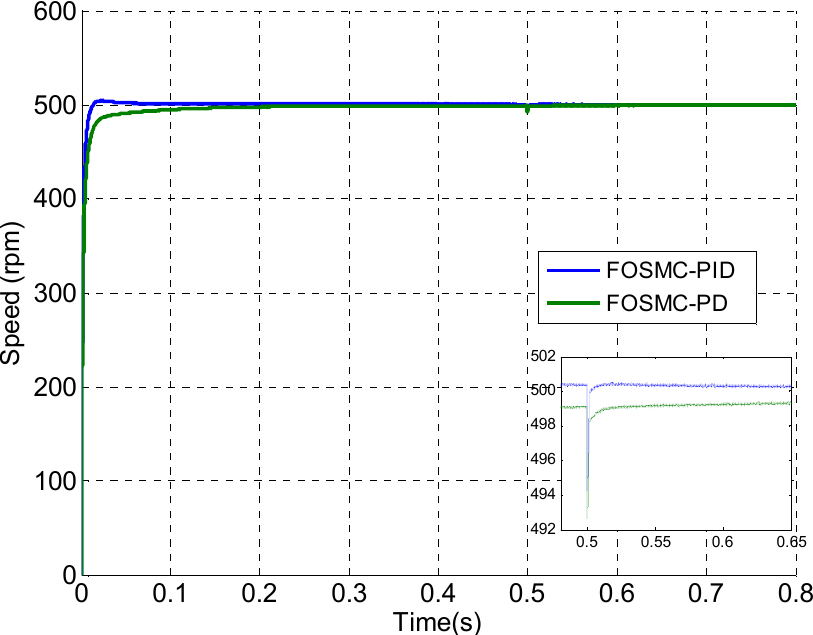
Figure 6. Speed response of FOSMC-PID and FOSMC-PD speed controller.